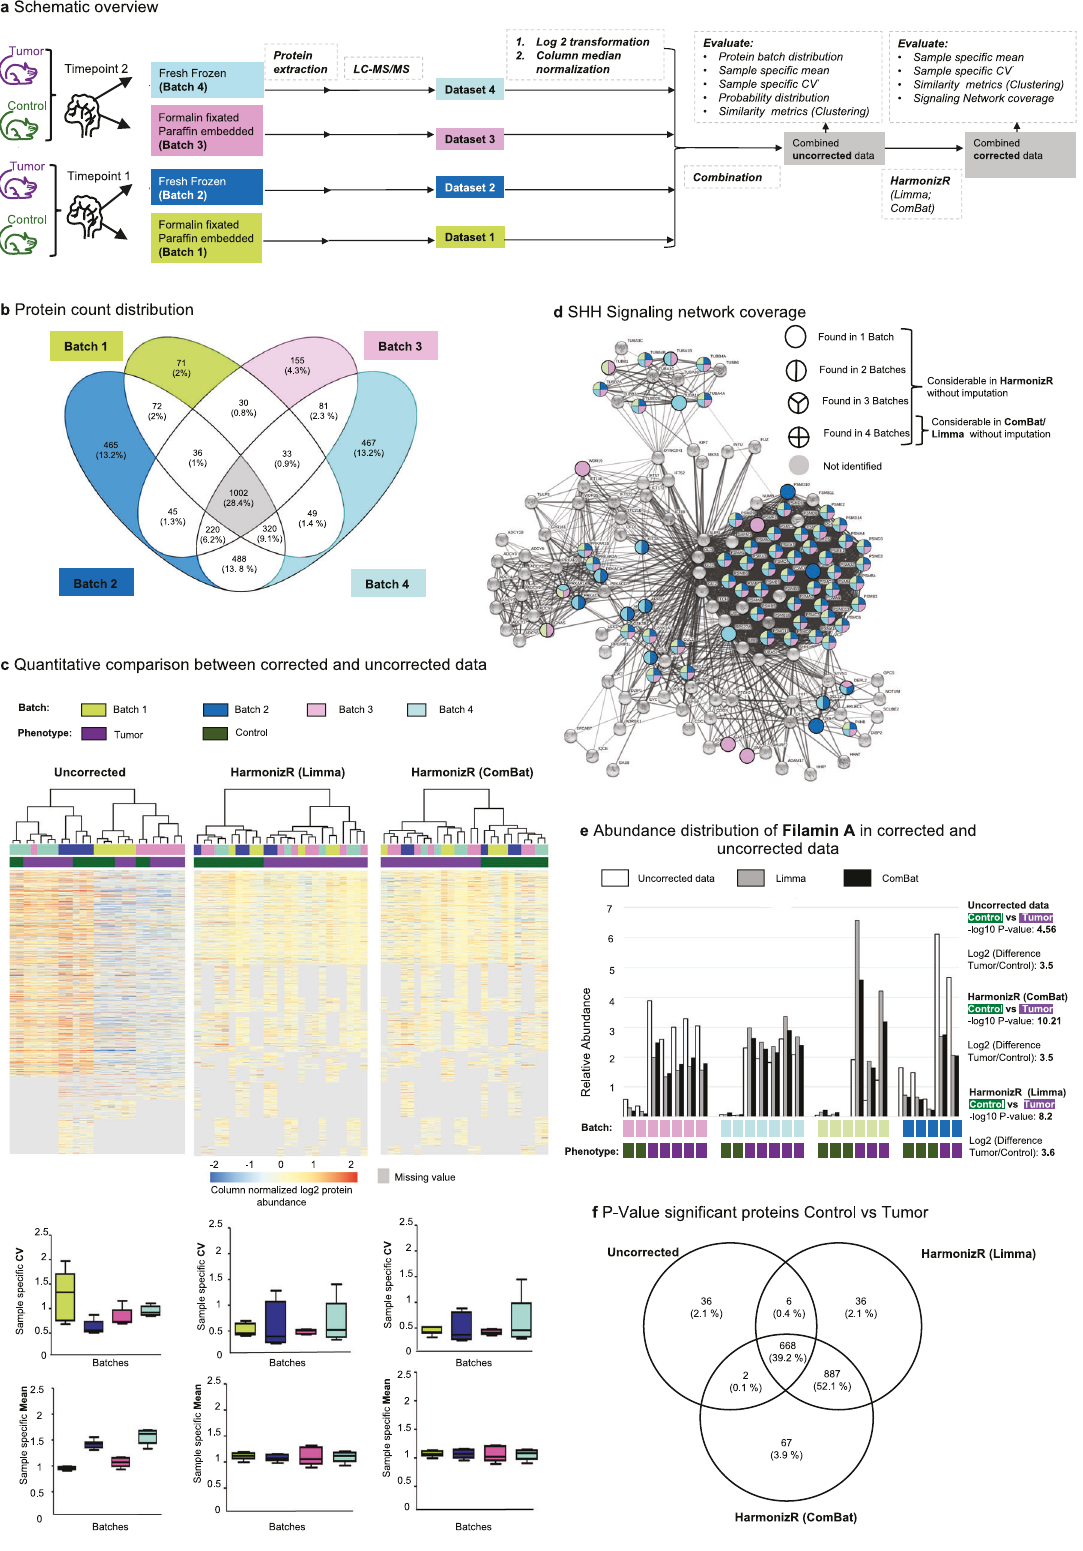
respective TMT batch. For iRS, batch effects were still visible in principle components (PCs) 1 to 3 (Fig. 4d, e; Supplementary Fig. 13). For all calculated PCs, no separation of 24 h cetuximab treated cells was observable. According to Stepath et al., no clear distinguishability of the divergent condition “ 24 h